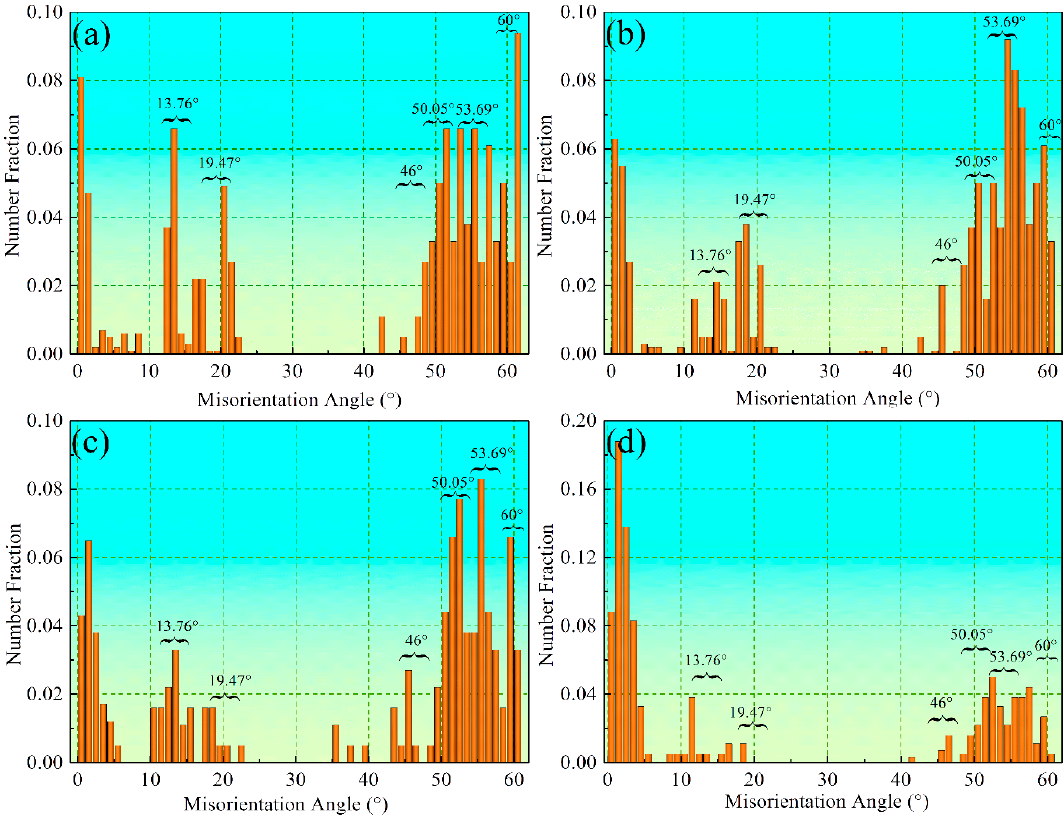
Figure 9. The misorientation angle/axis distribution for the given austenite grain transformed to bainite at different temperatures of ( a ) 200 °C; ( b ) 250 °C; ( c ) 300 °C and ( d ) 350 °C.